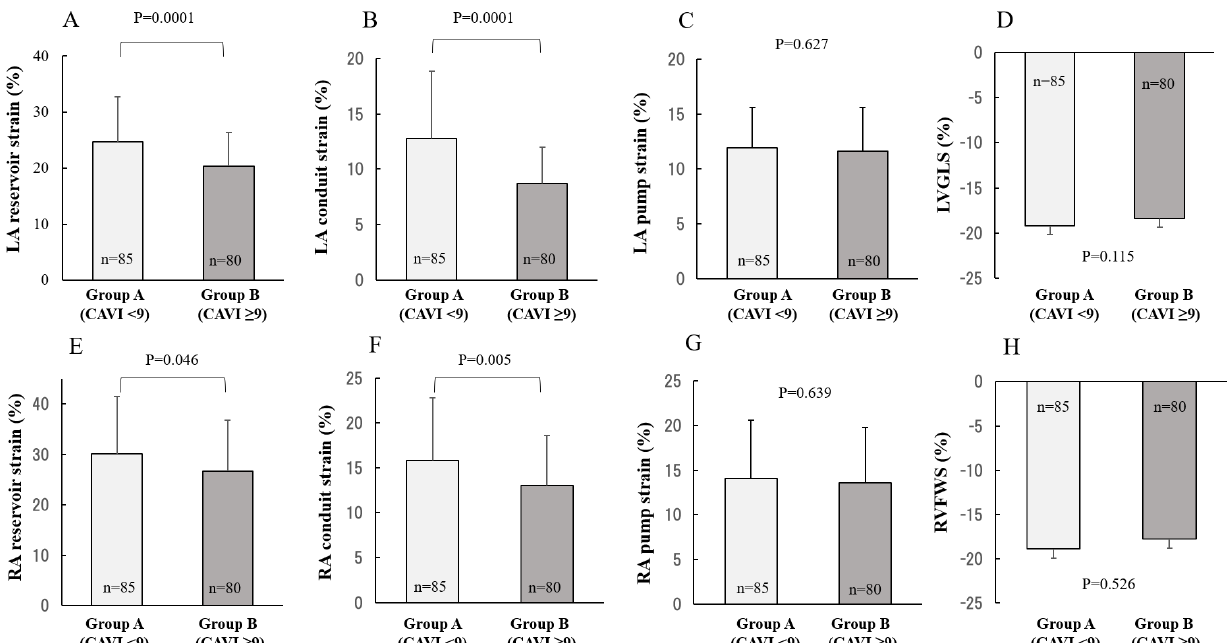
Figure 1. Comparison of biatrial and biventricular strain in the CAVI value. Biatrial reservoir and conduit strain in those with abnormal CAVI were significantly lower than those with normal CAVI. Data are presented as mean ± standard deviation. CAVI, cardio-ankle vascular index; LA, left atrium; RA, right atrium; LVGLS, left ventricular global longitudinal strain; RVFWS, right ventric- ular free wall longitudinal strain.